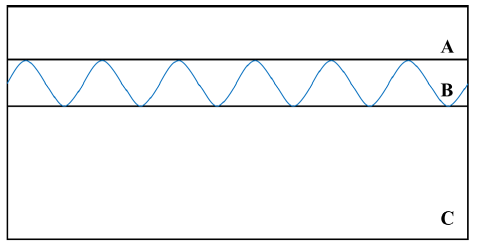
Figure 6. Simplified diagram of the problem.